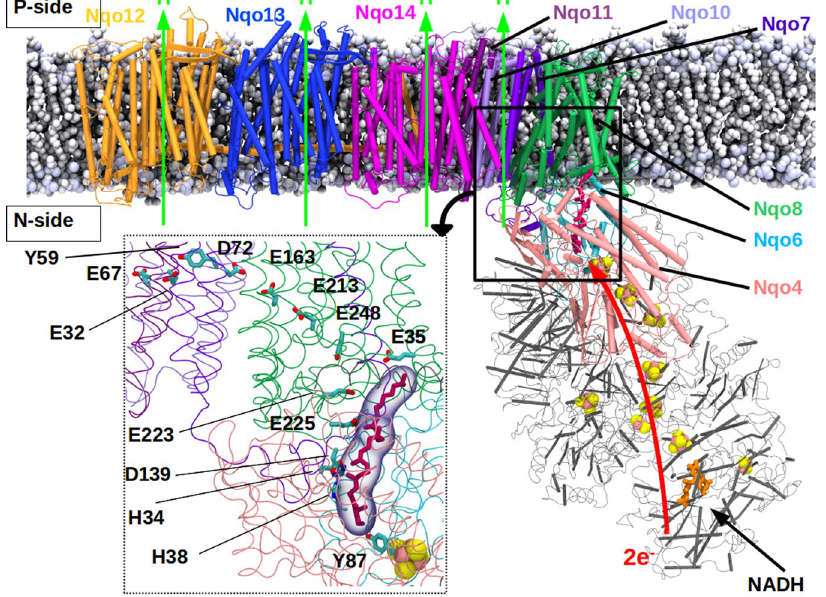
Figure 1. Structure of respiratory complex I embedded in lipid-solvent environment. The membrane- embedded antiporter-type subunits Nqo12–14 are shown in orange, blue and magenta, respectively. Nqo8 (green), Nqo7, Nqo10 and Nqo11 (violet-indigo) are also displayed along with the hydrophilic subunits Nqo6 (light blue) and Nqo4 (pink) that form the Q-binding site scaffold. Q (purple) binds in a buried binding site. All other hydrophilic subunits are shown in grey. Covalently-bound FeS clusters (pink-yellow spheres), and FMN (orange) at the terminal end of the hydrophilic domain are also shown. NADH binds next to FMN and acts as a direct donor of two electrons to the latter. The region studied in this work is marked by a thick black box, and is shown to atomic details in the inset (box with dotted lines). The residues discussed in this work are also marked